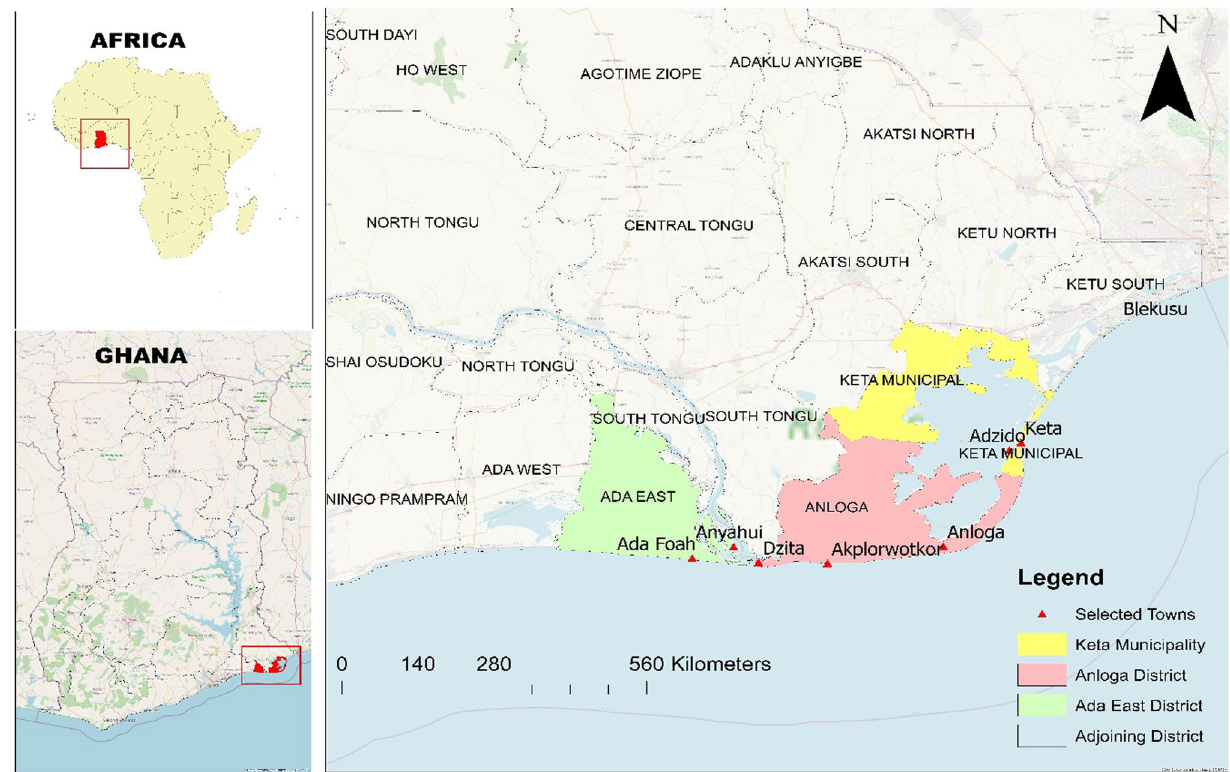
Fig. 3 Location of the Study